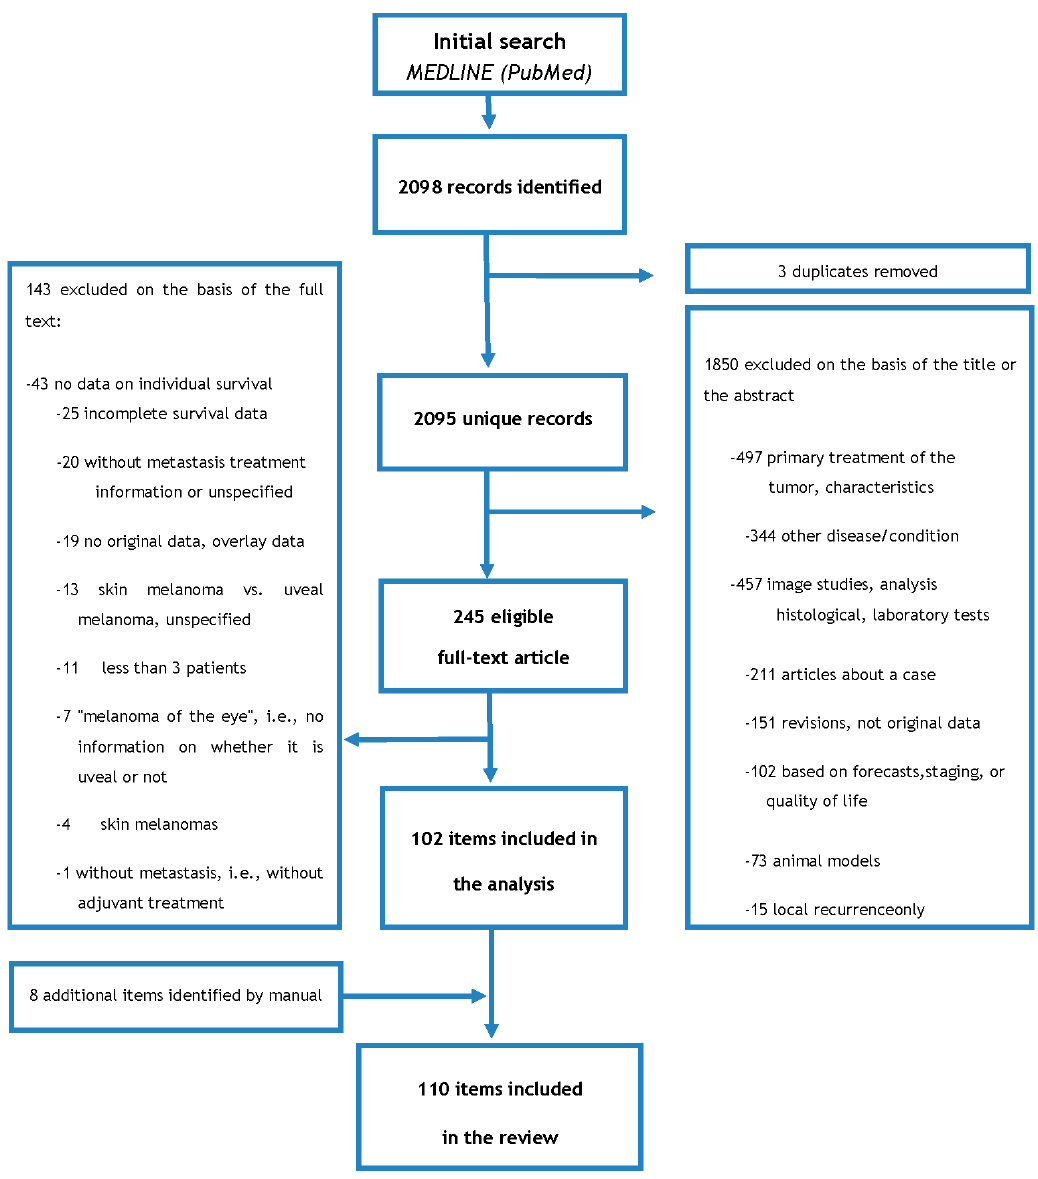
Figure 6. Article selection flowchart.